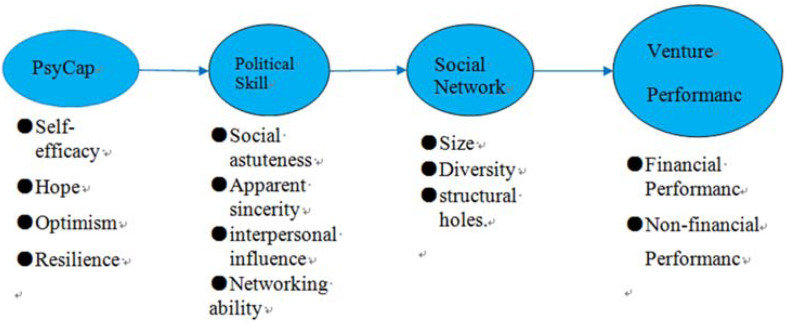
Conceptual scheme.